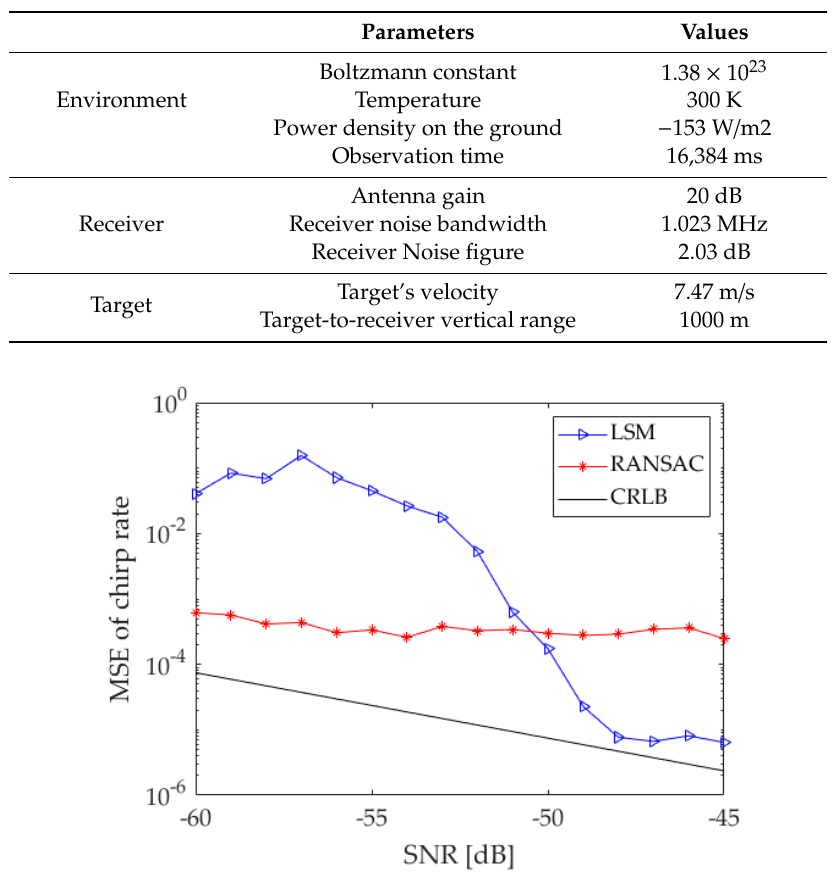
Table 5. Simulation parameters for chirp rate estimation.